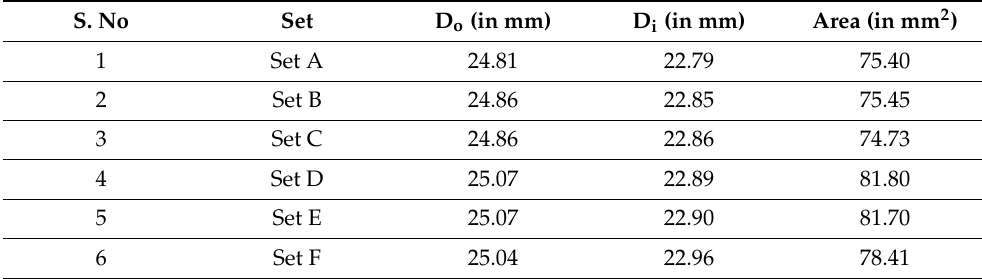
Figure 7. 3D surface roughness map for turned sample. Table 5. Table showing final dimensions of cylinders. Average values after adjusting Vernier measurements for average surface roughness S a calculated from confocal microscopy.